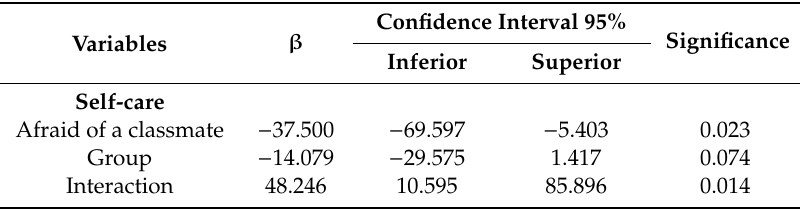
Figure 5. Interaction “Afraid of a classmate” with Group on Self-care with Group. FXS = Fragile X Syndrome. CG = control group. Table 9. Interaction “Afraid of a classmate” with Group on Self-care with Group. FXS = Fragile X Syndrome. CG = control group (central tendency and